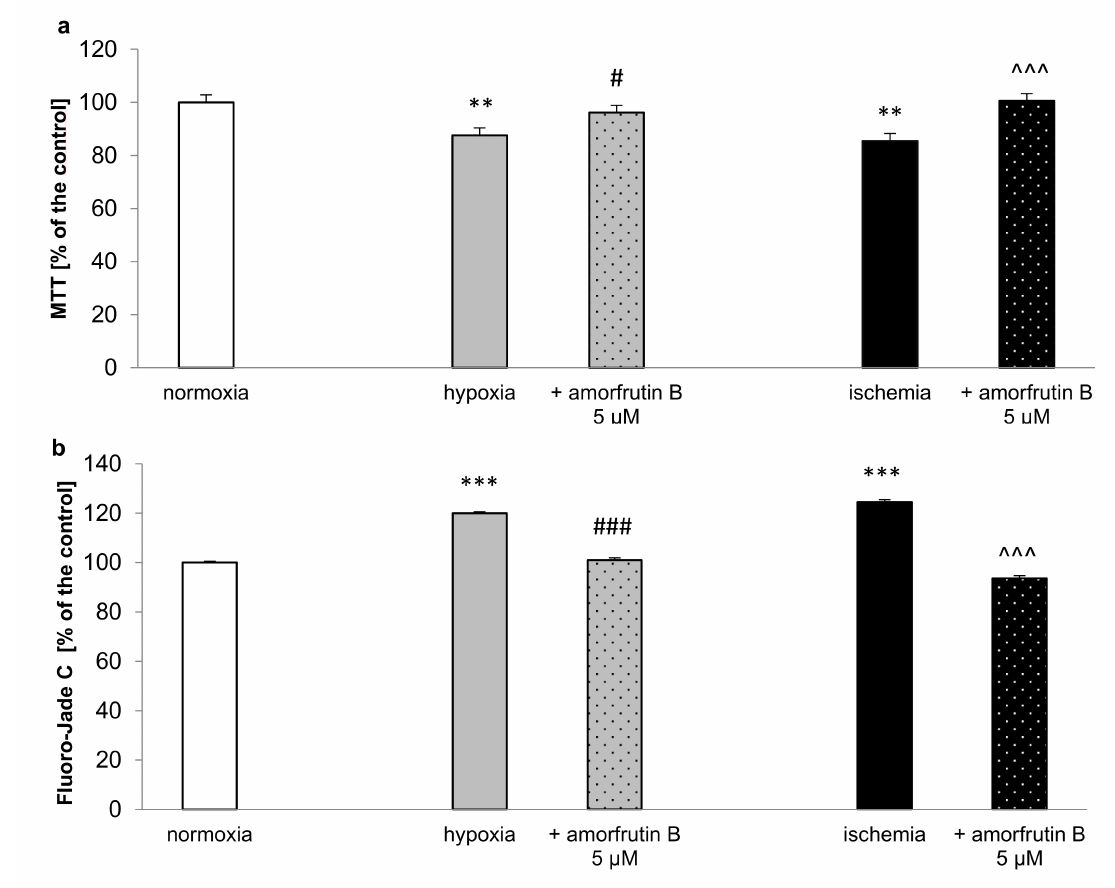
Figure 2. Amorfrutin B (5 µ M) reversed the hypoxic- and ischemic-induced loss in viability and reduced neurodegeneration of primary neocortical cell cultures. Hypoxia and ischemia decreased the viability ( a ) and increased the degeneration ( b ) of neuronal cells, and amorfrutin B manifested its neuroprotection by elevated levels of viable cells and reduced neurodegener- ation, respectively. The results are presented as a percentage of the control ± SEM of 3 independent experiments, consisting of 8–12 replicates per group. ** p < 0.01 and *** p < 0.001 compared to the control group, # p < 0.05 and ### p < 0.001 compared to the cultures exposed to hypoxia, ˆˆˆ p < 0.001 compared to the cultures exposed to